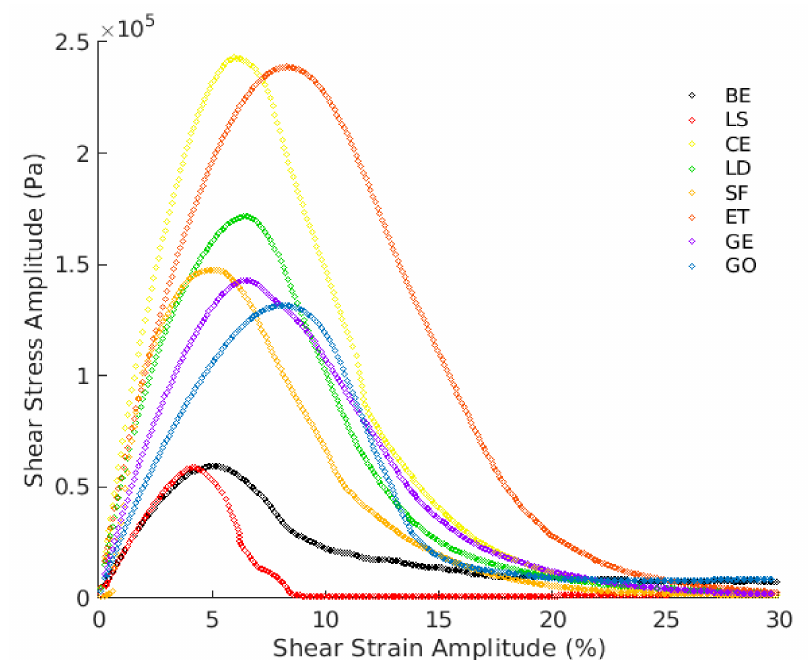
Figure 11. Shear stress–strain of di ff erent mastics.